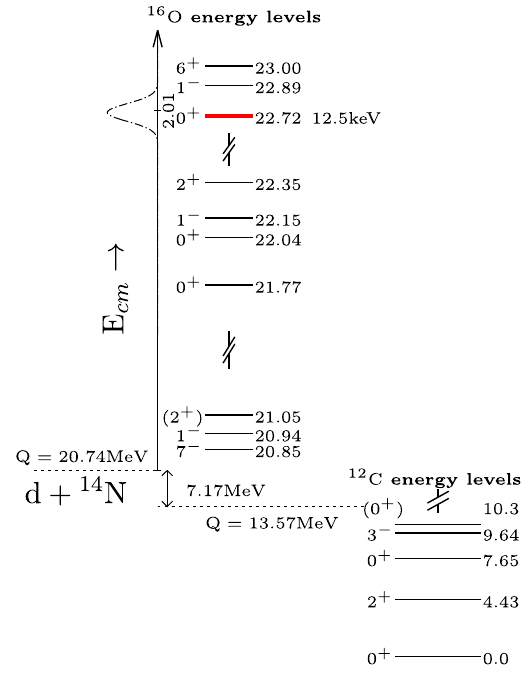
FIG. 12. 16 O nuclear level scheme. On the left, the entrance channel (d þ 14 N) is marked. On the right, α emission to different excited states in 12 C is also